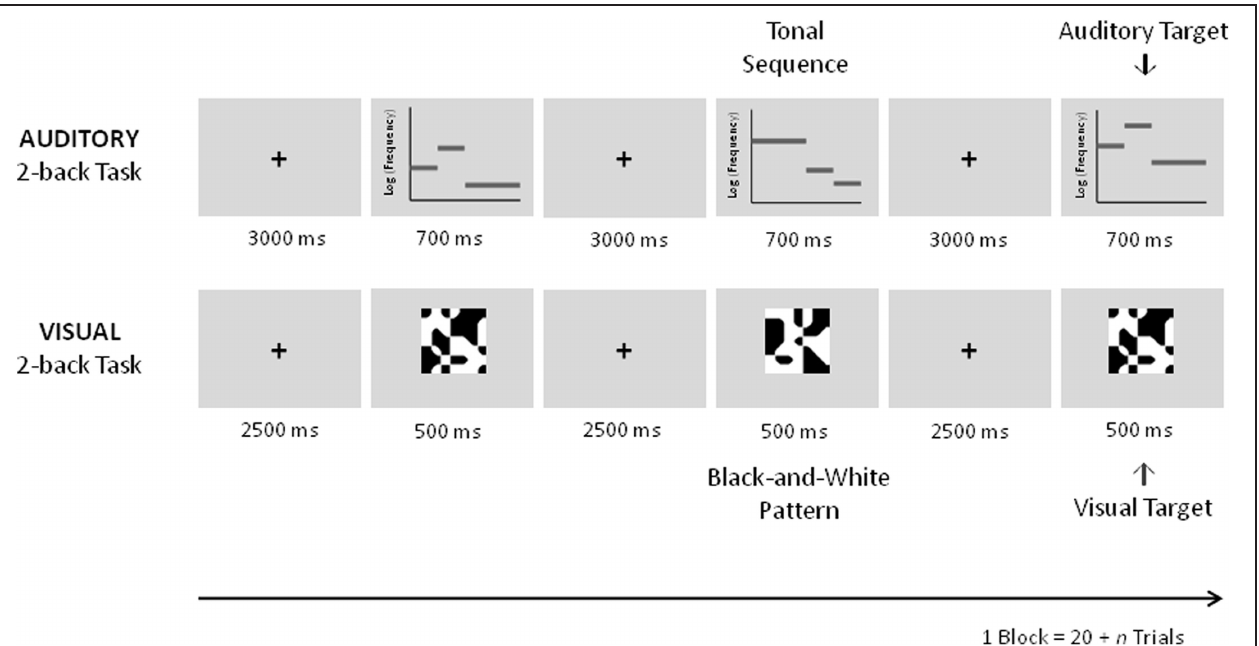
FIGURE 3 | Schematic description of the auditory and visual 2-back transfer tasks in the pre and posttest fMRI sessions. In the auditory task equivalent auditory tonal sequences as during training were used. In the visual black-and-white pattern stimuli were used.